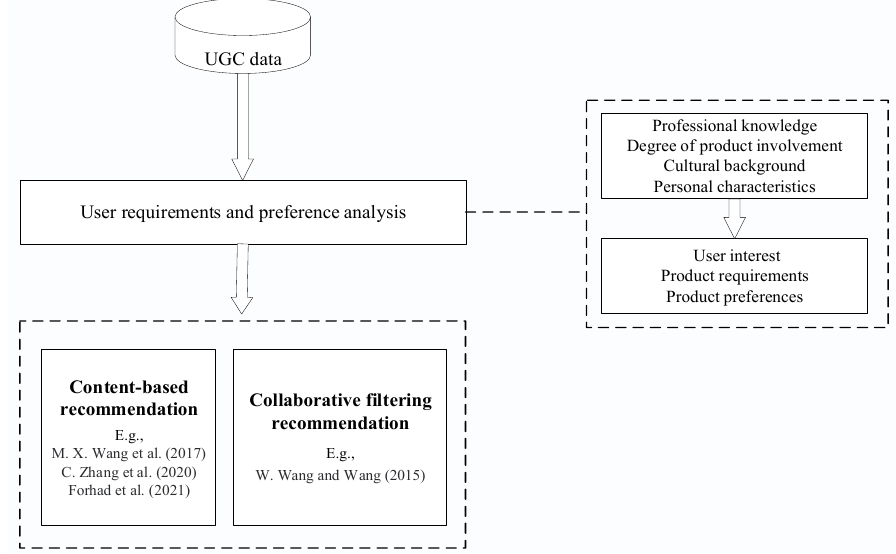
Figure 5. Requirement identification and recommendation system [97,98,110,131].